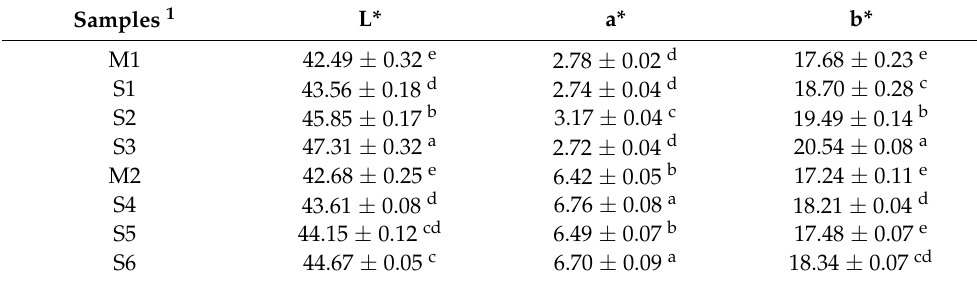
Table 4. Color parameters of walnut butter samples.